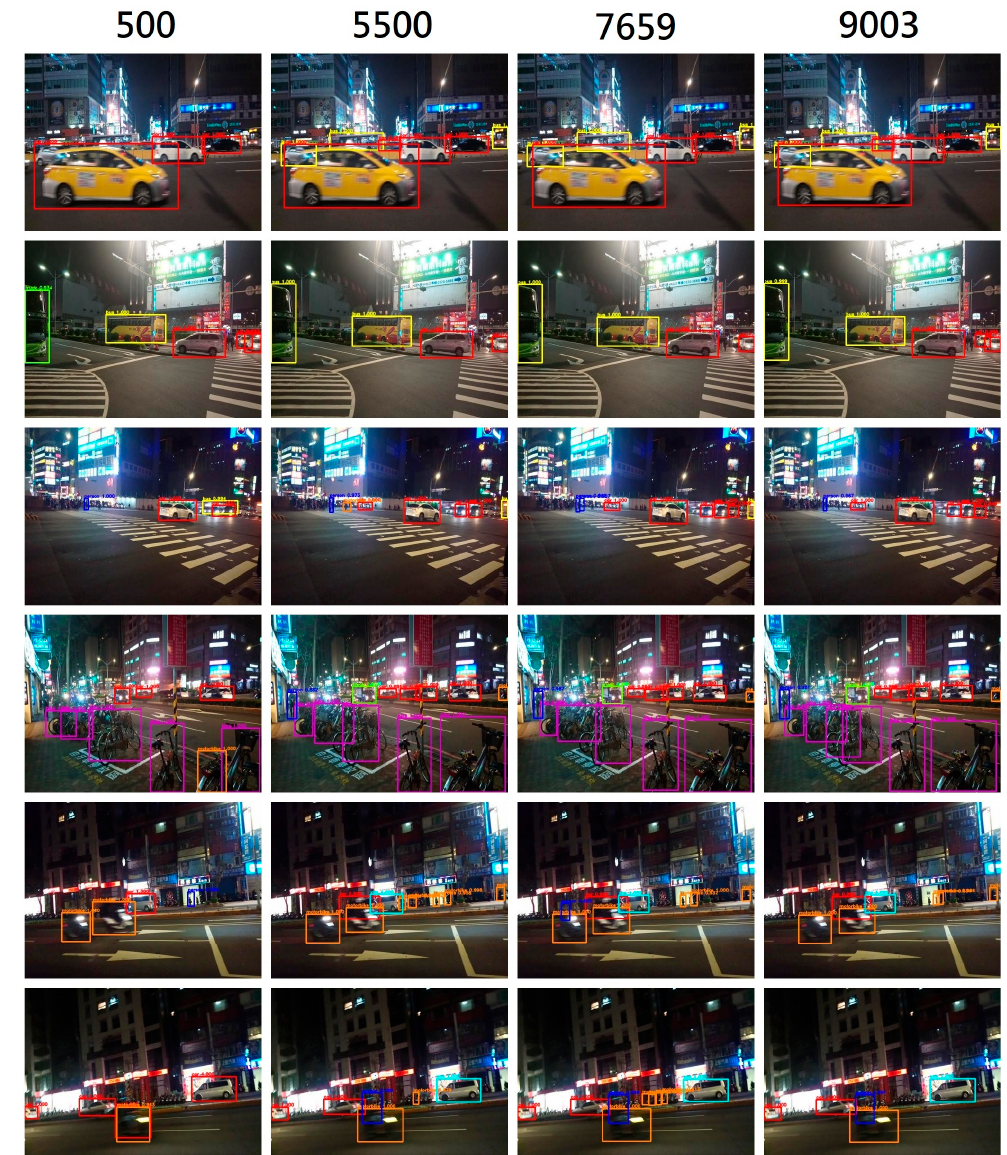
Figure 15. Faster R-CNN [5] with ResNet101 [2] trained with different amounts of our nighttime